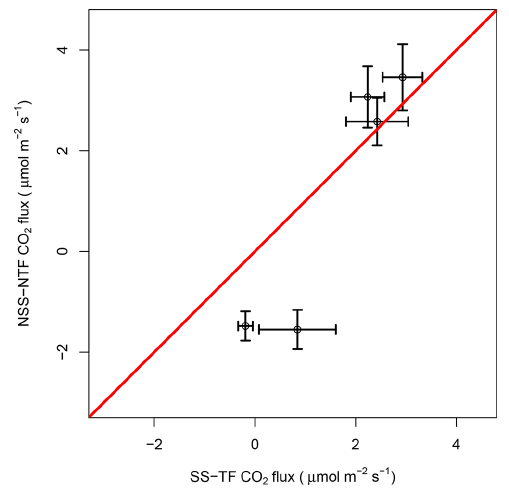
Figure 8. Comparison of SS-TF and NSS-NTF CO 2 fluxes during a short campaign at the CRAM station between 1 and 2 June